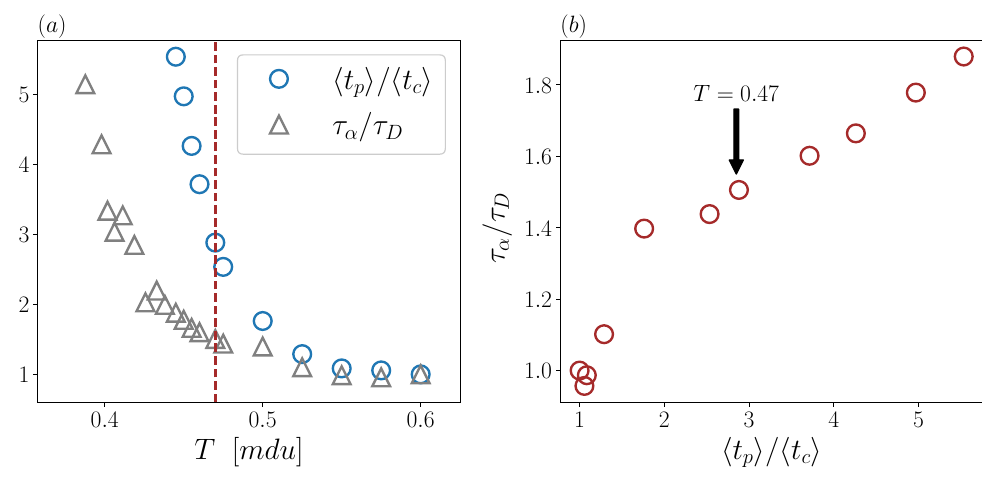
Figure 2. ( a ) τ α and (cid:104) t p (cid:105) as a function of temperature. Ratios of microscopic and macroscopic τ D t c (cid:104) (cid:105) timescales have been divided by their own value at T = 0.6, which is the highest available temperature for the CJ dataset. Red vertical line indicates T = 0.47 ( b ) Scatter plot of the macroscopic versus microscopic timescales ratios, rescaled as in panel ( a